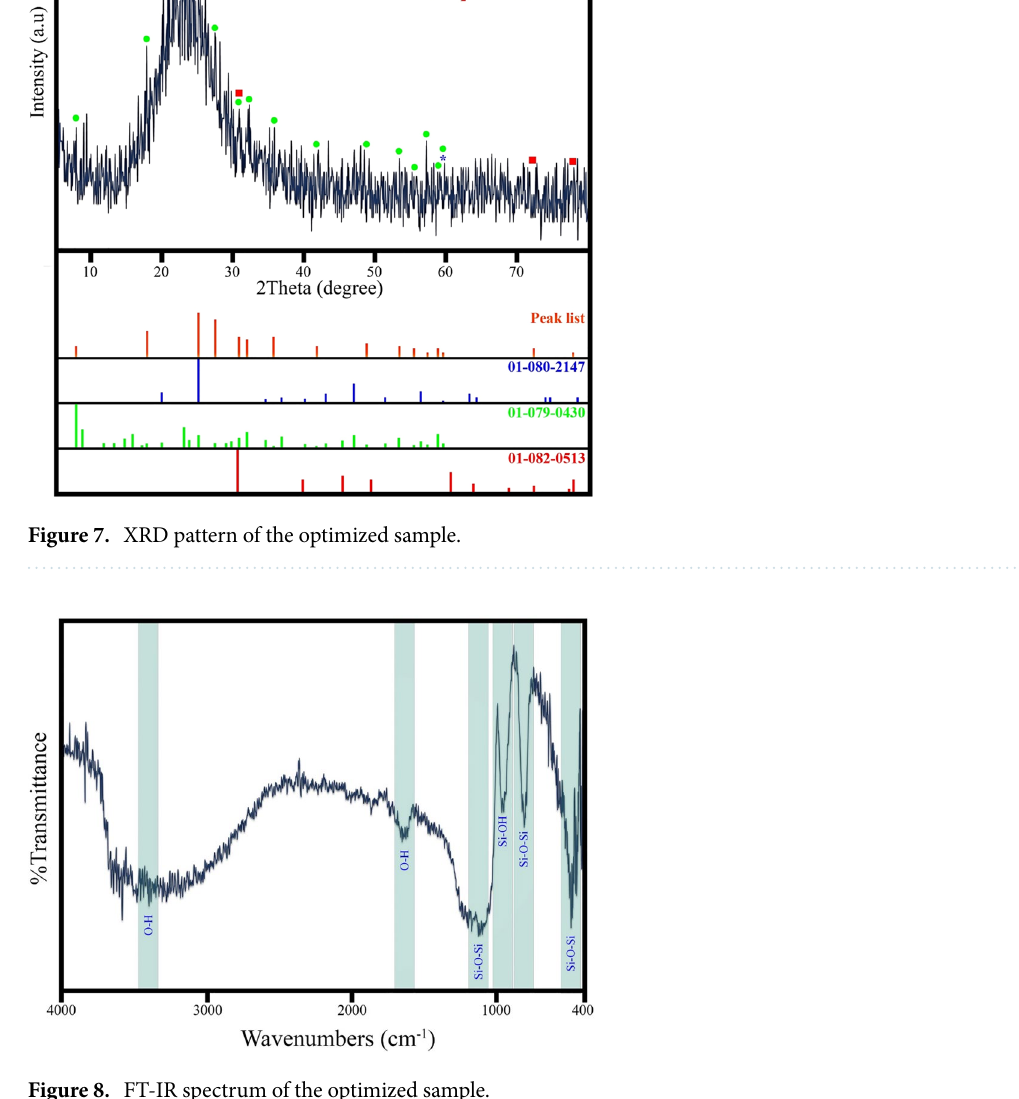
Figure 8. FT-IR spectrum of the optimized